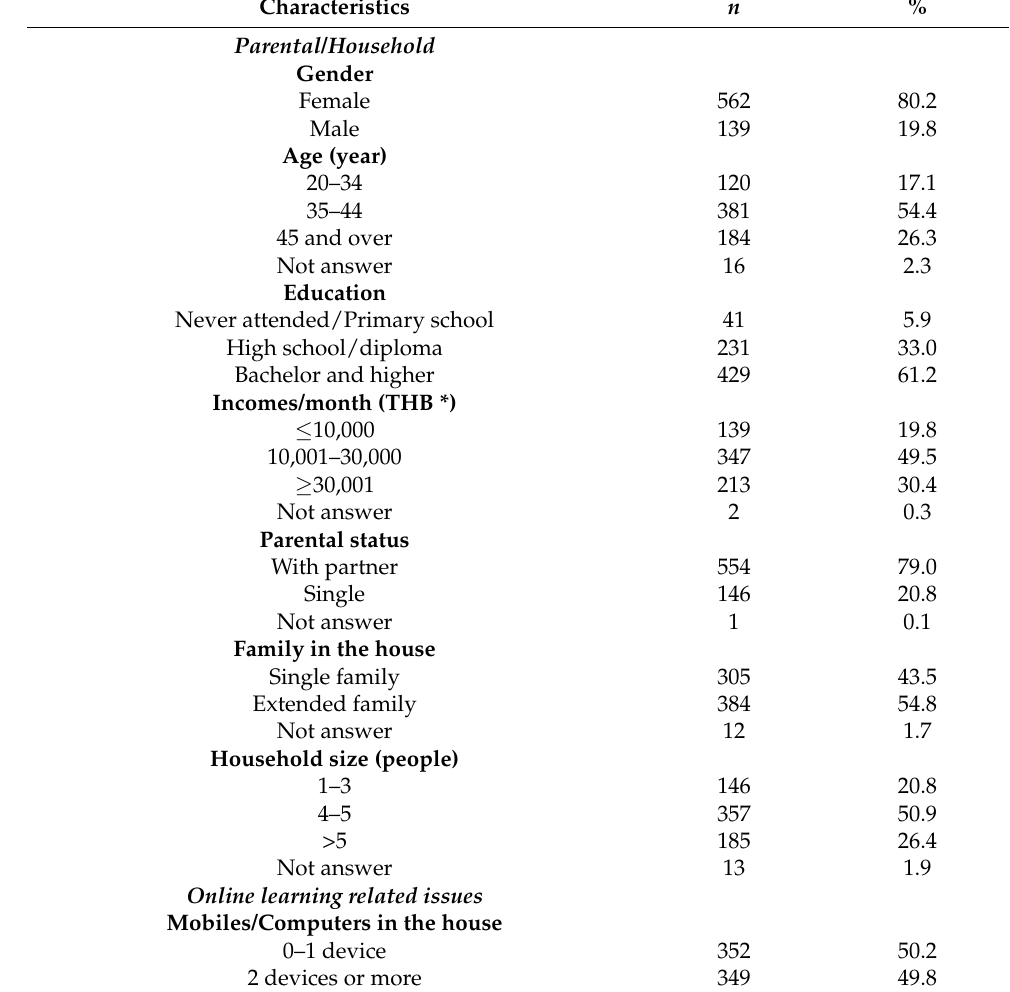
Table 1. Characteristics of parents, household, children, and online learning related issues ( n = 701). Characteristics n %